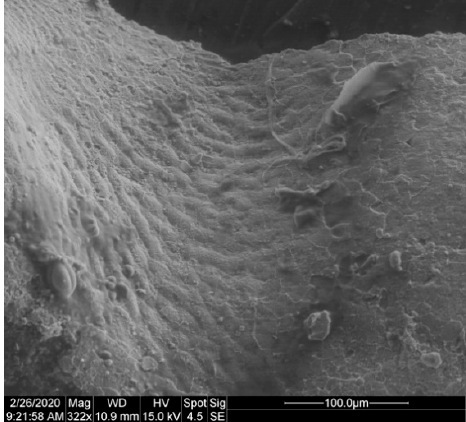
Figure 34. Cambroarchilocus tigris gen. nov. sp. nov. Paratype. Right shield, anterior to right. Detail of ‘fingerprint’ ridges in the sulcus anterior to the posterodorsal node. IGM 3614 (43). Photo Credit: Mark